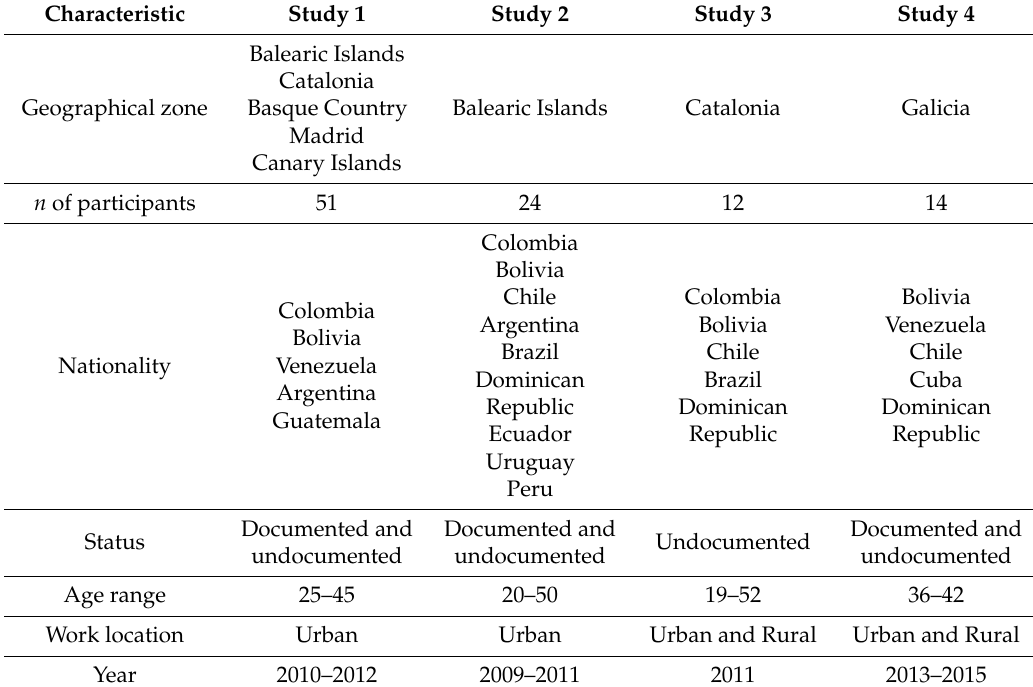
Table 1. Characteristics of the sample and original